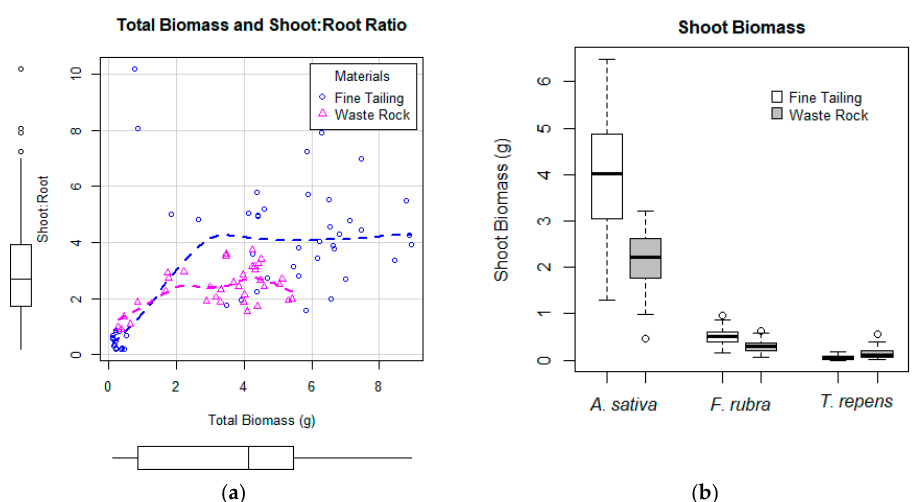
Figure 4. ( a ) Dry weight biomass and shoot:root ratio of herbaceous and woody species, compared between fi ne tailing and waste rock growth materials after 3 months of growth. The loess regression curve shows a tendency of constant shoot:root ratio on bigger plants. ( b ) The biomass yield of herbaceous species on fine tailing material tends to be higher compared to that on waste rock material. The statistical analysis is shown for fi xed e ff ects in Table S1 and for random e ff ects in